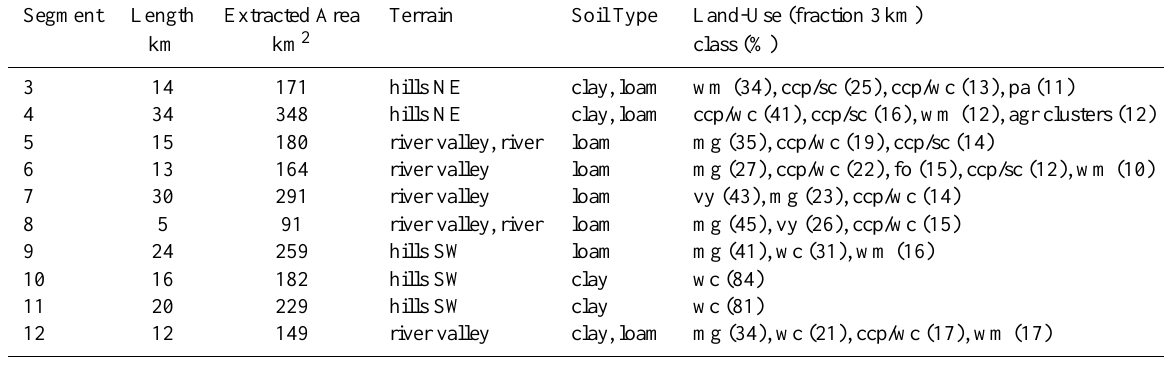
Table 2. Landscape characteristics of segments with 3-km width at both sides along flight tracks in the CERES experimental domain (See text for abbreviations). Land-use fractions of more than 10% are listed below.